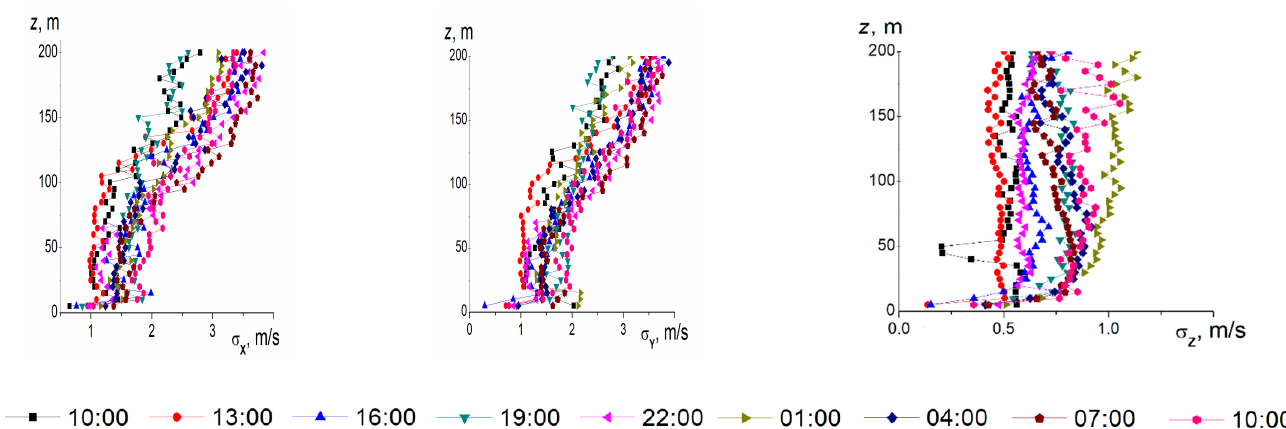
Figure 4. Diurnal dynamics (in 3 h) of the standard deviations of the wind vector components averaged over 10-min periods retrieved from minisodar measurements on 16–17 September.